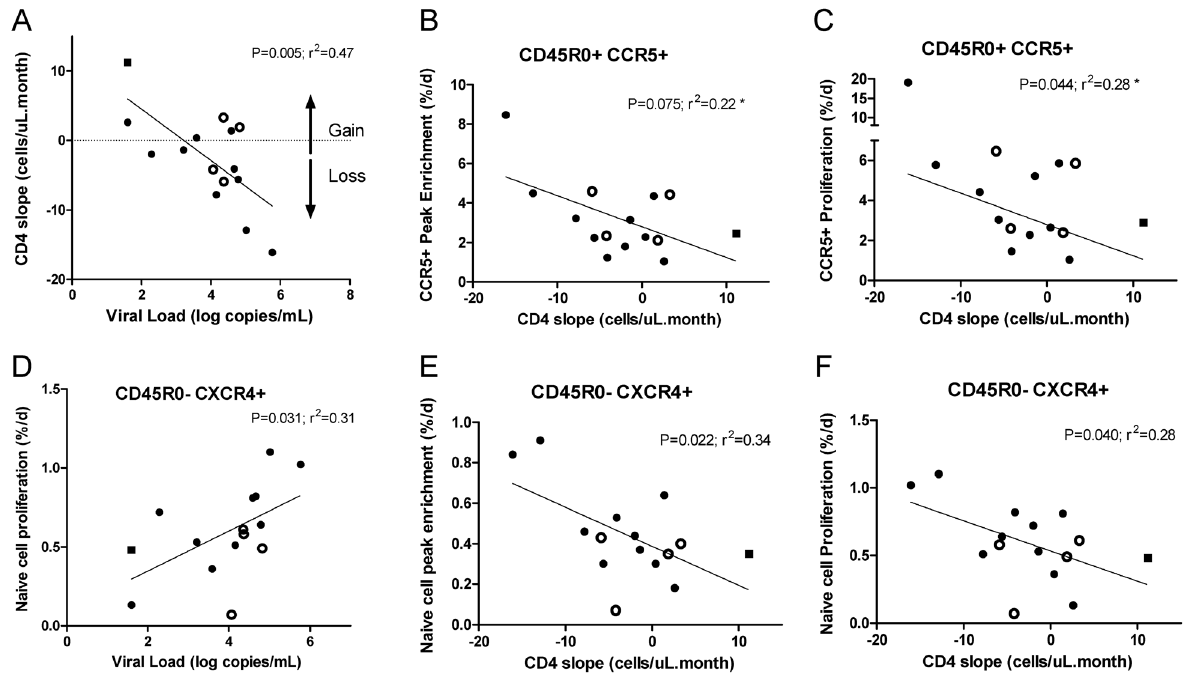
Figure 5. Correlates of CD4 cell loss in HIV-infected subjects. Relationship of CD4 slope with viral load in all HIV-infected subjects (A); each symbol represents a single subject; closed circles, R5-tropic subjects; open symbols, X4-tropic subjects; closed square, treated subject (RH07R); undetectable viral load was attributed the value of 40 copies/mL (the detection threshold), or 1.6 as log 10 . CD4 cell loss was expressed as a rate of decline in the months preceding in vivo kinetic studies. Relationship of viral load and CD4 slope with kinetic parameters in memory (CD45R0 + CCR5 + ) (B, C) and naı¨ve (CD45R0 2 CXCR4 + ) (D, E, F) CD4 + T-cells; symbols as frame (A); analysis by Pearson linear regression, * log transformed for skewed CCR5 +